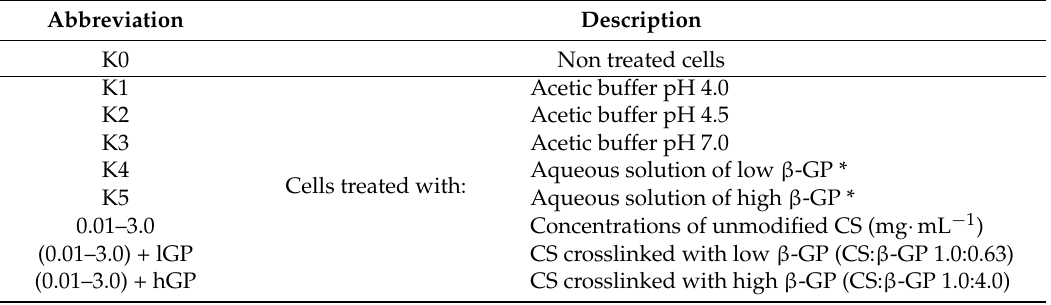
Table 5. Abbreviations used in the in vitro cytotoxicity